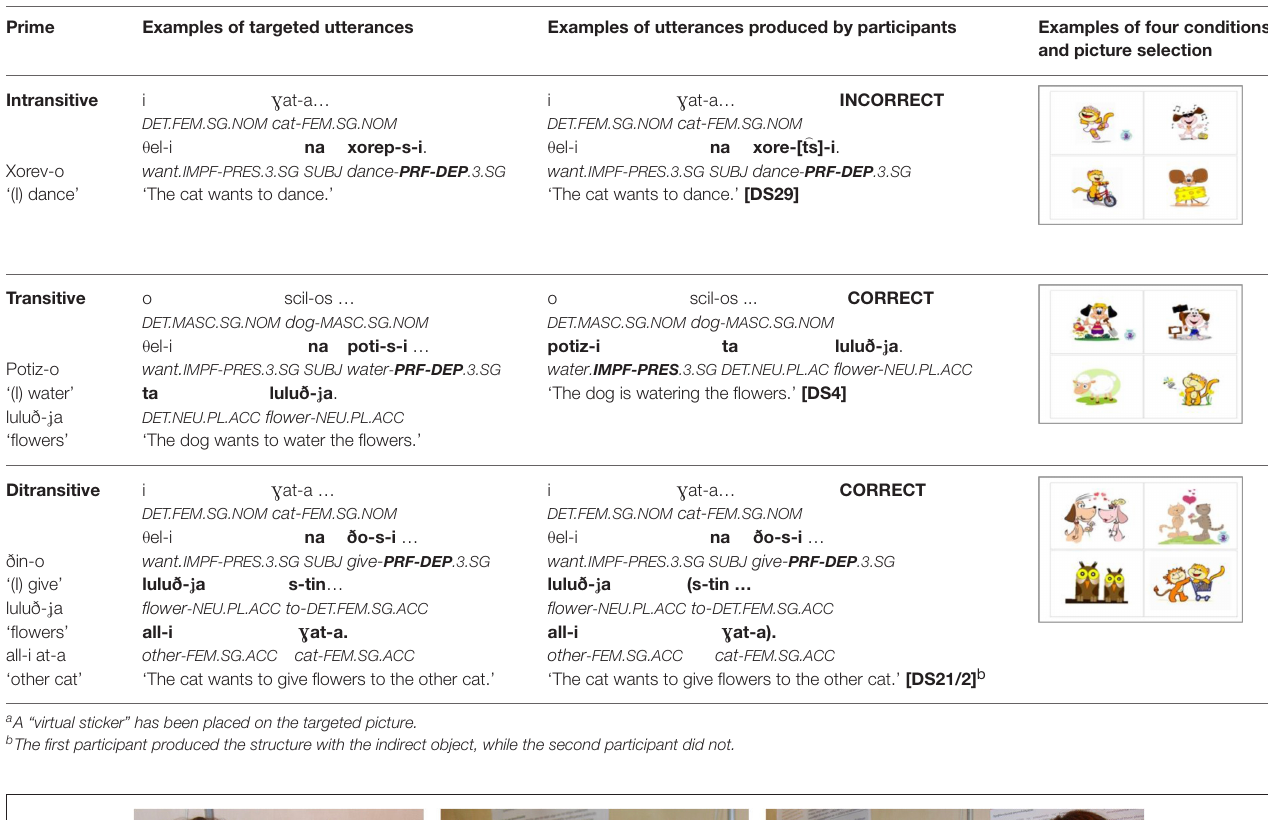
TABLE 2 | Structural environments tested by the act-out priming production task a . Prime Examples of targeted utterances Examples of utterances produced by participants Examples of four conditions